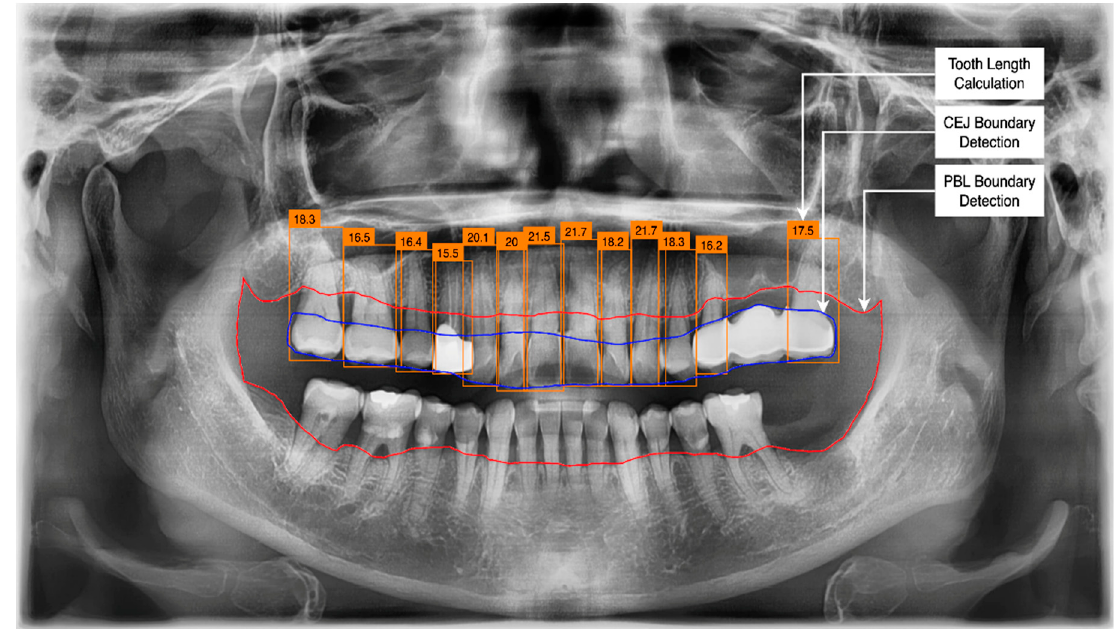
Figure 9. PBL and CEJ boundaries detection using U-Net models.